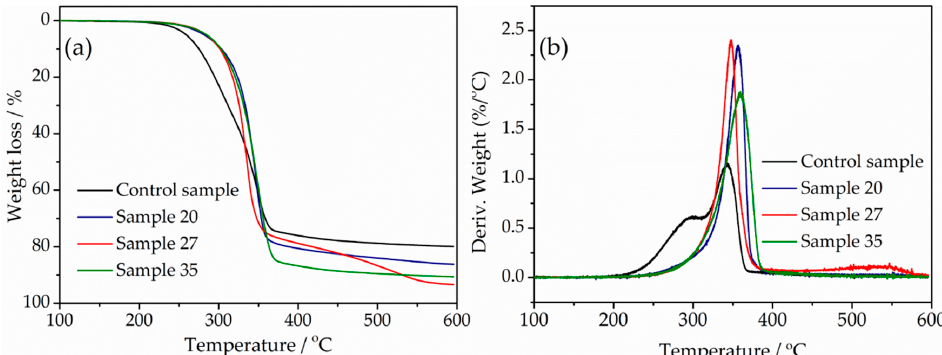
Figure 6. TGA and DTG curves of the control sample and SCB acetate (sample 20), propionate (sample 27) and butyrate (sample 35).